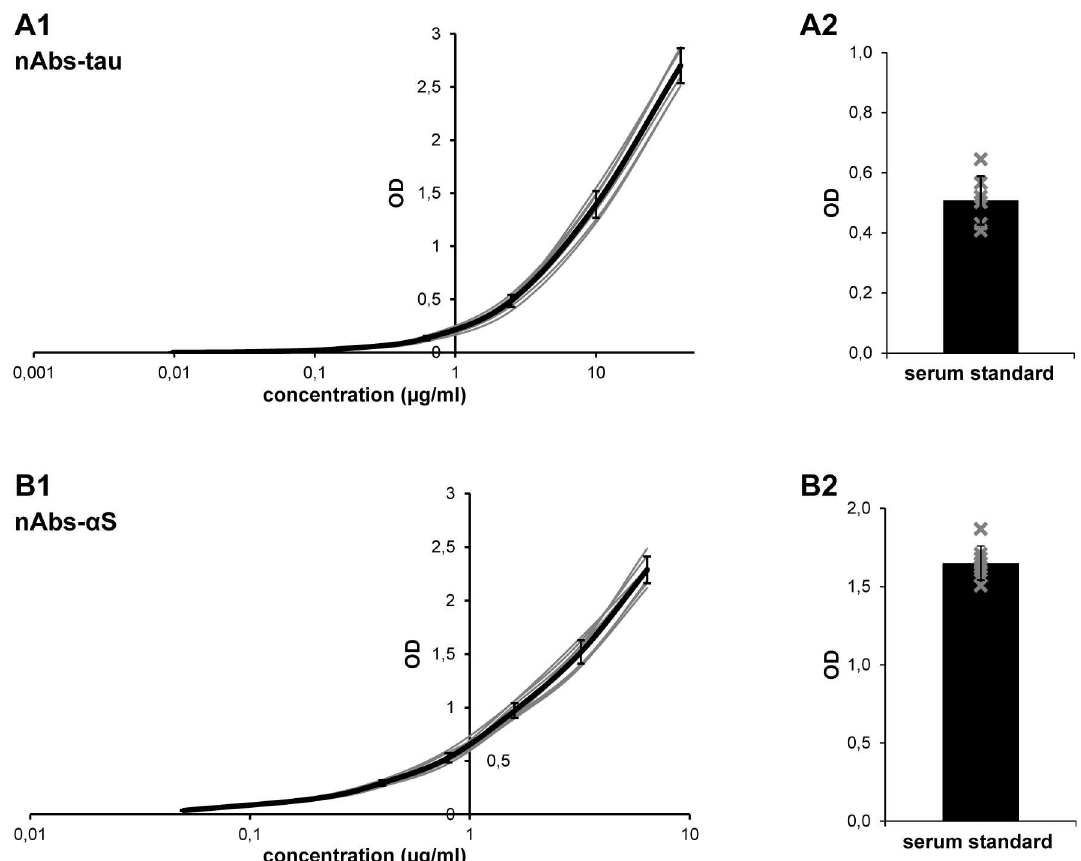
Fig 1. Interassay variance. Figure shows standard curves (A1, B1) of single ELISA plates (grey) and mean standard curves (black) of nAbs-tau-ELISA (A1) and nAbs- α S-ELISA (B1). Furthermore, single (grey crosses) and mean ODs of the pooledserum standard (A2, B2) are displayedfor nAbs-tau-ELISA (A2) and nAbs- α S-ELISA (B). Data are shown as the mean ±